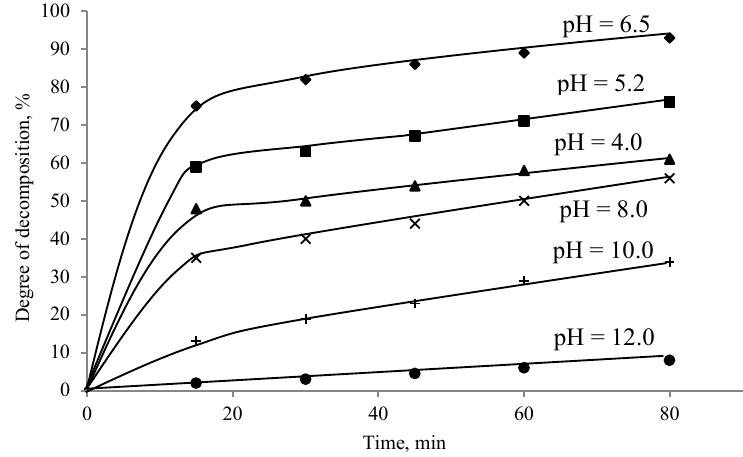
Fig. 8. Dependence of the degree of decomposition of phenol on the processing time and pH of the solution.